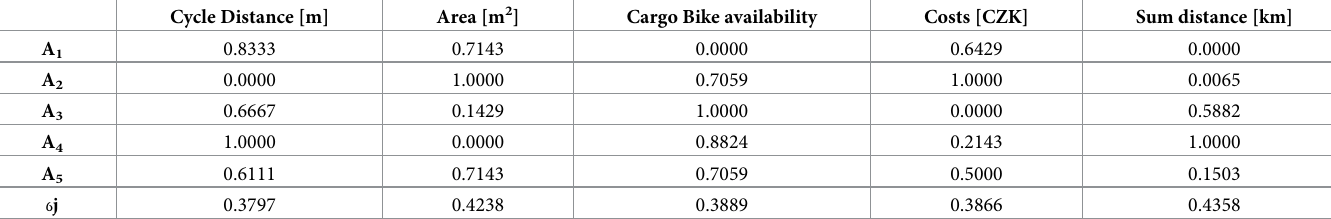
Table 13. Normalization of the initial decision-making matrix with the standard deviation ỽ j.